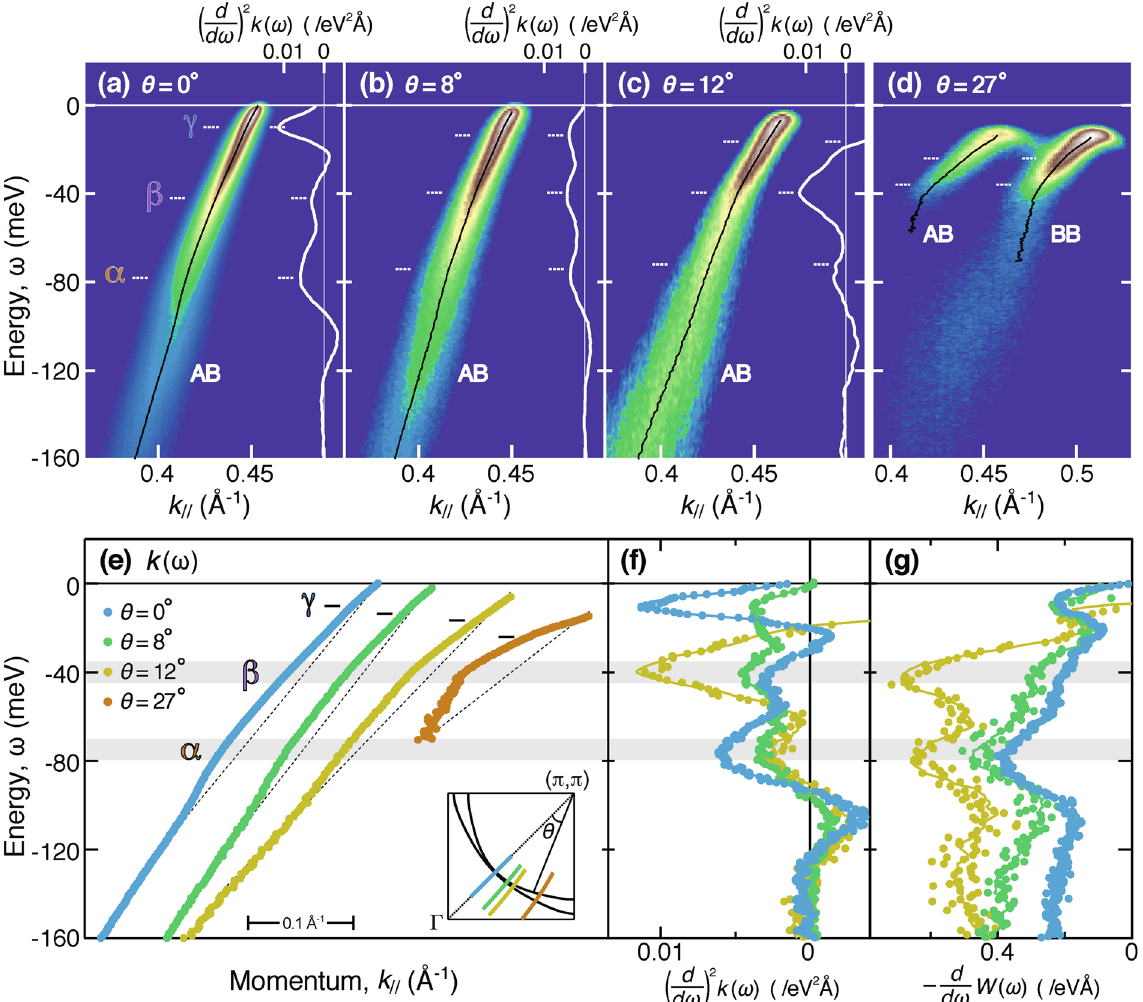
( e ). Black and white curves denote the MDC peak dispersion, k ( ω ) (bottom axis), and its second energy derivative, ( d / d ω ) 2 k ( ω ) (top axis), respectively. In panel ( d ), the bonding band (BB) and antibonding band (AB) are simultaneously observed with h ν = 8.5 eV, whereas in panels ( a – c ), the AB is selectively observed with h ν = 7.0 eV 19 . ( e ) Offset plot of the dispersion, k ( ω ), taken from ( a – d ). Dashed lines are guides to the eye. Three kinks are labelled α , β , and γ from high to low binding energies. ( f ) Superimposed plot of ( d / d ω ) 2 k ( ω ) taken from ( a – c ). ( g ) Energy derivative of MDC peak width, − dW ( ω )/ d ω